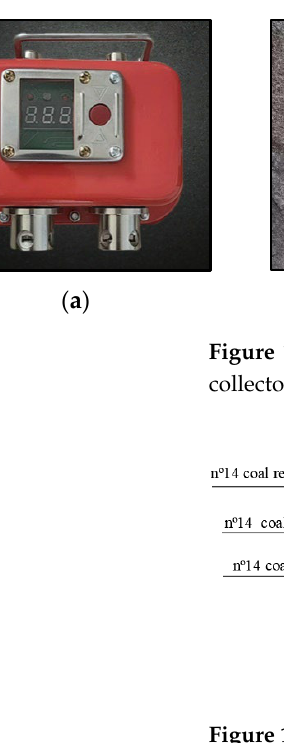
Figure 12. The location of the stress sensor.